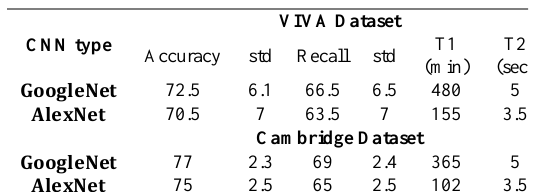
Table 3. Mean and standard deviation of accuracy and recall. T1 and T2 represent the training and testing times, respectively. std: standard